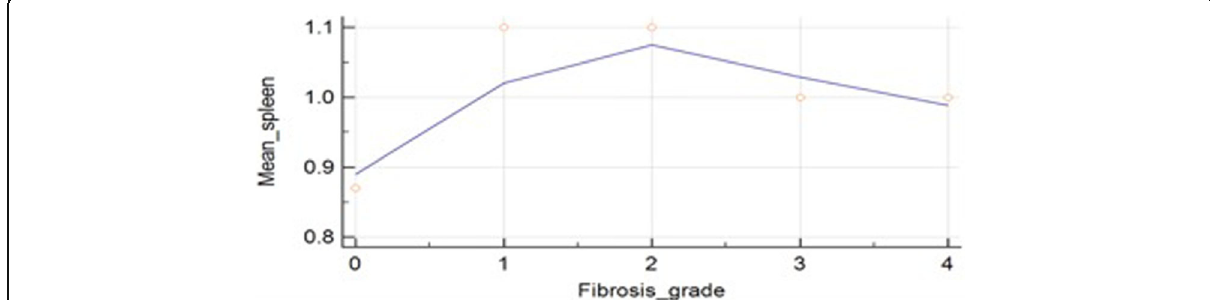
Fig. 2 Shows no significant correlation between mean spleen ADC in different fibrosis stages. (Spearman's rank correlation coefficient rs = 0.105; 95% CI: − 0.153 – 0.350, p = 0.866).